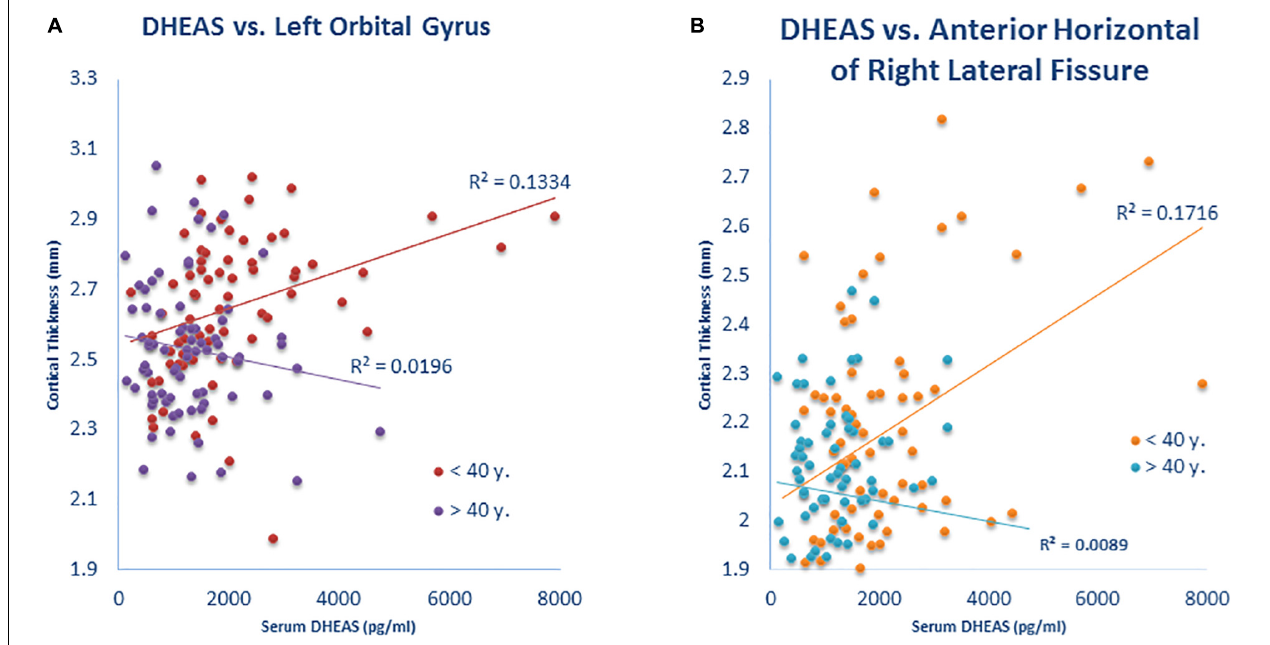
FIGURE 3 | Interaction of neurosteroid level × age is associated with cortical thickness. (A) Participants under 40 years showed a positive correlation ( r = 0.365) of DHEAS with cortical thickness in the left orbital gyrus but the correlation was not present ( r = –0.140) in participants over 40 years ( Z = 3.08; p = 0.002). (B) Participants under 40 years showed a positive correlation ( r = 0.414) of DHEAS with cortical thickness in the anterior horizontal portion of the right lateral fissure but the correlation was not present ( r = –0.094) in participants over 40 years ( Z = 3.14; p = 0.002).